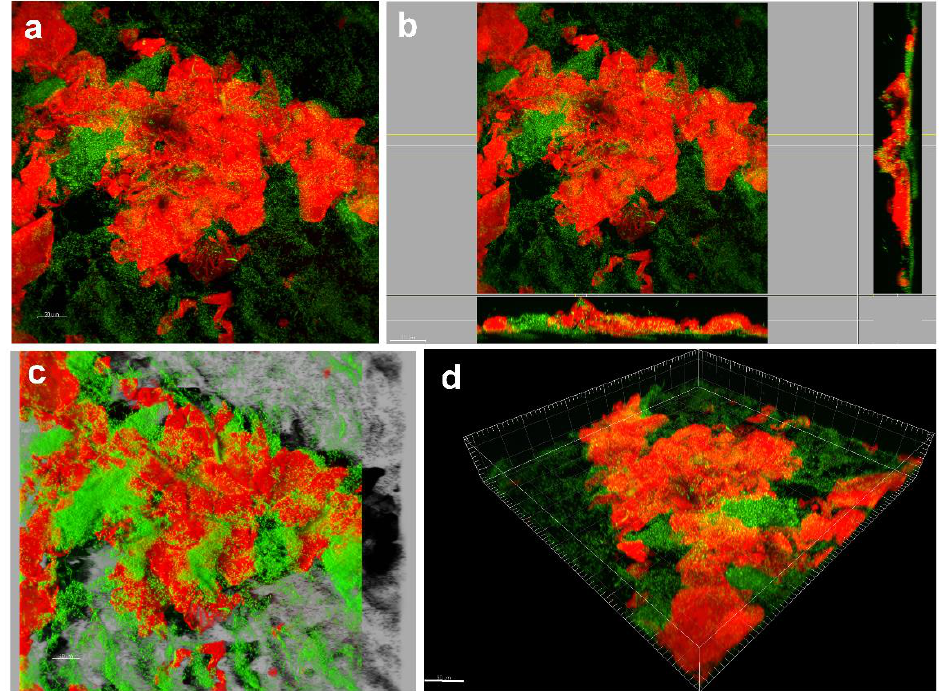
Figure 5. Comparison of di ff erent computer visualizations of a single confocal laser scanning microscopy (CLSM) image of E. coli biofilm grown on low density polyethylene surface. Computational analysis has been performed by Imaris software. ( a ) maximum intensity projection; ( b ) orthogonal projection; ( c ) blend projection and ( d ) 3D reconstruction. Biofilm was stained green with Syber green I (live cells) and red with Texas Red-labelled ConA (polysaccharidic